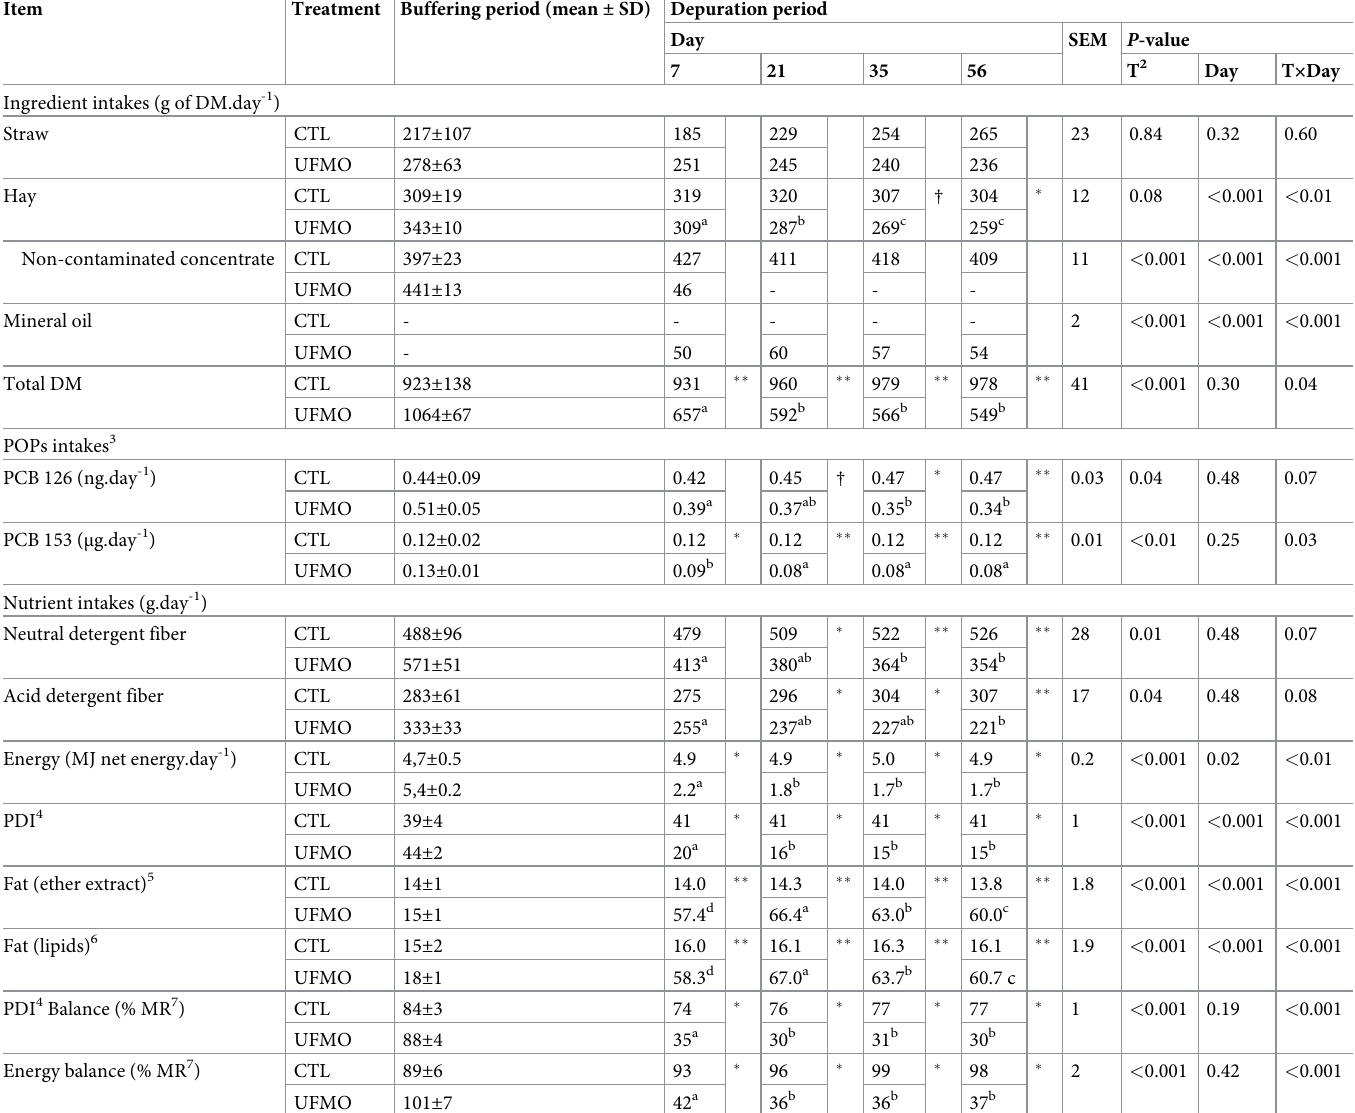
Table 2. Ingredients, nutrients and POPs intakes of ewes 1 during the buffering and depuration periods.